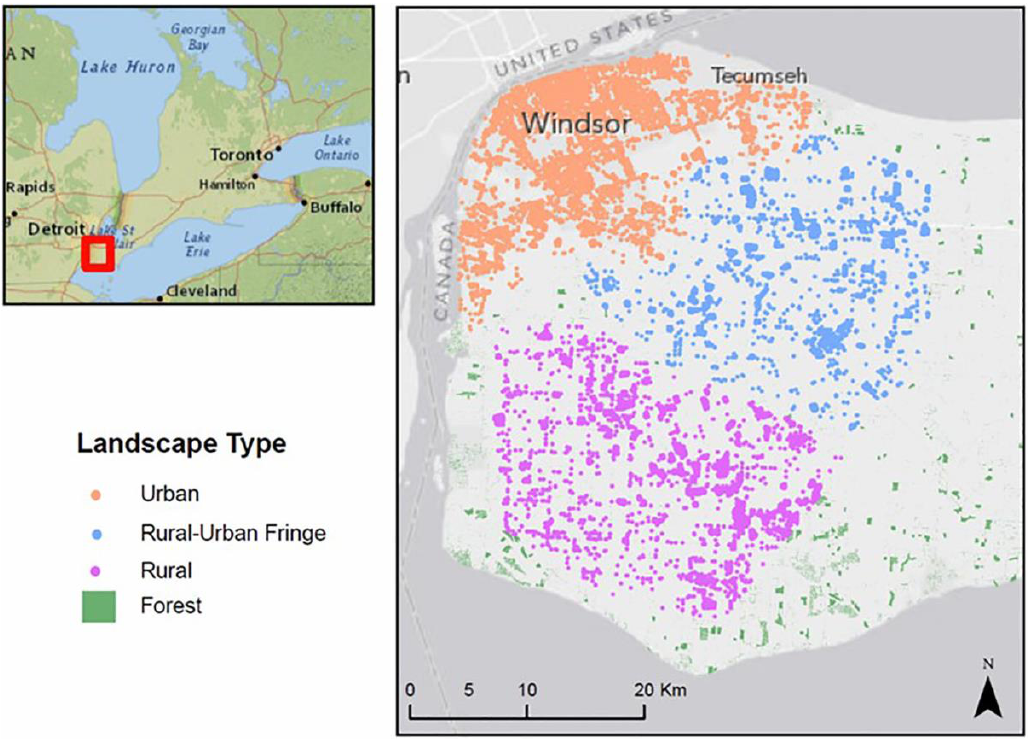
Figure 1. Study site, Windsor, Canada, depicting different spatial patterns of the ash trees characterizing three landscapes: urban, rural-urban fringe and rural.